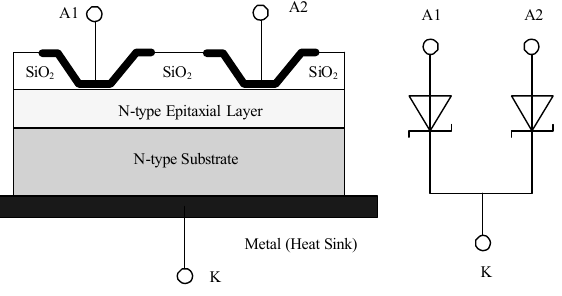
Figure 1. Structural diagram of a twin diode.